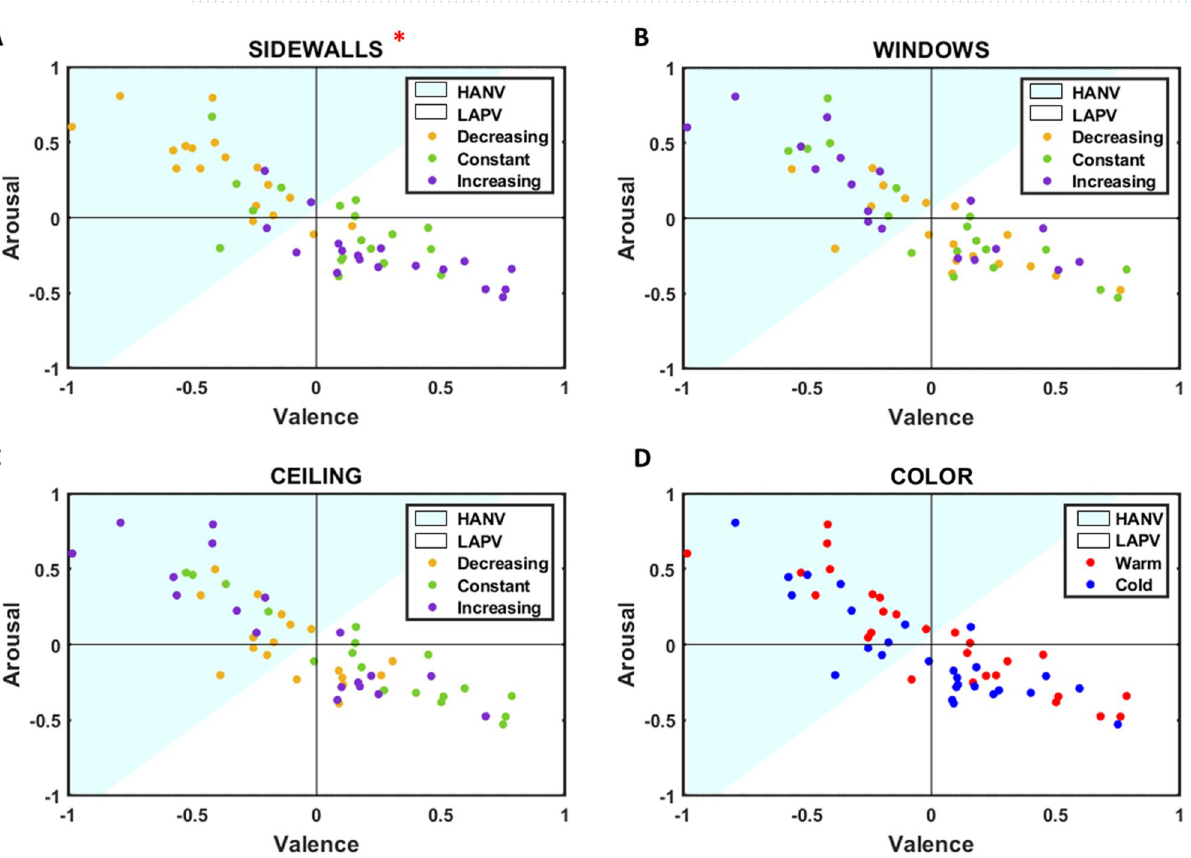
Figure 6. For each panel, the blue section of the plane includes the architectural designs belonging to the HANV cluster, while the white one comprises those designs within the LAPV cluster. ( A – C ) Yellow, green, and purple dots identify environments with decreasing, constant and increasing conditions for SideWalls, Windows, and Ceiling factors, respectively. ( D ) Blue and red dots identify architectural designs with cold and warm texture colors, respectively. The red asterisk indicates statistically significant